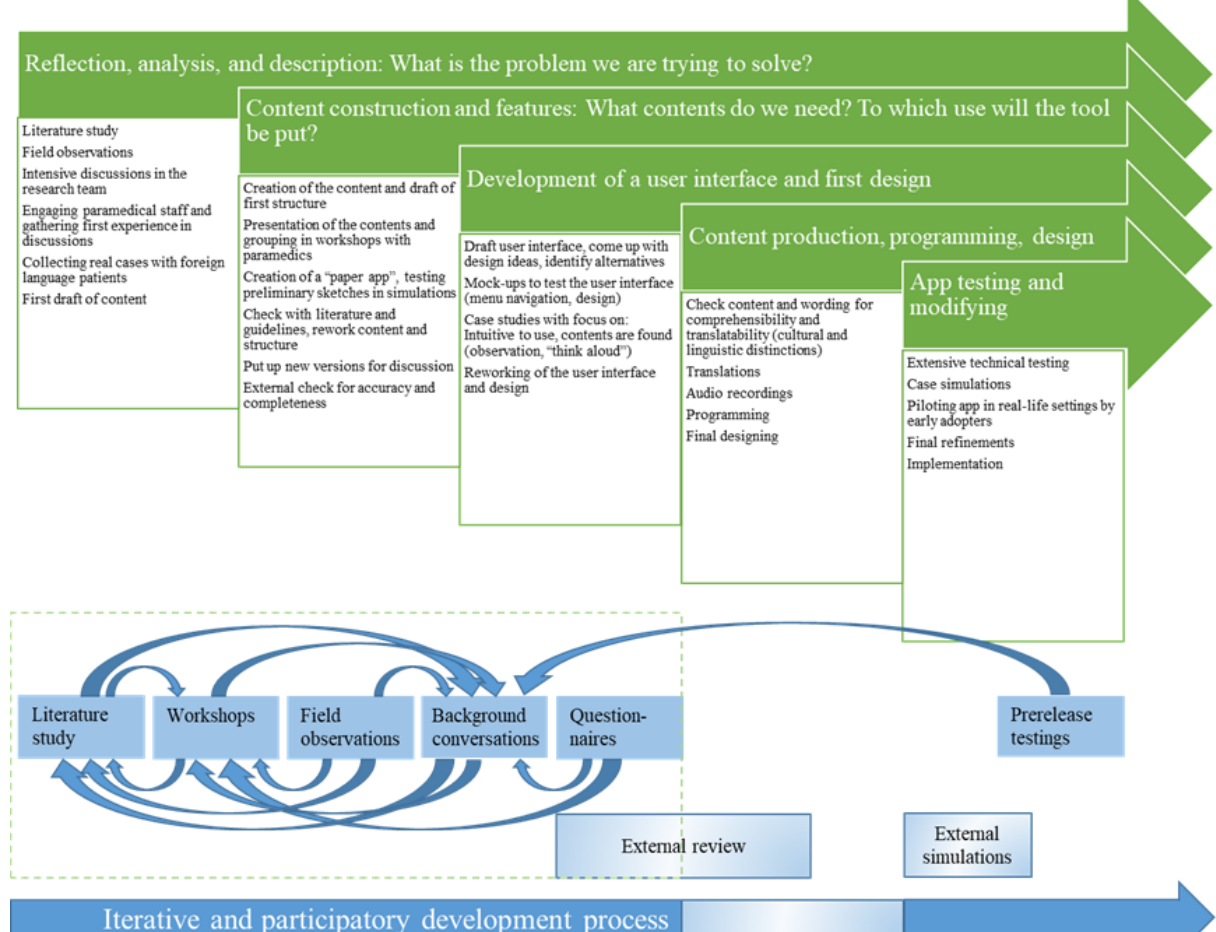
Figure 2. App development